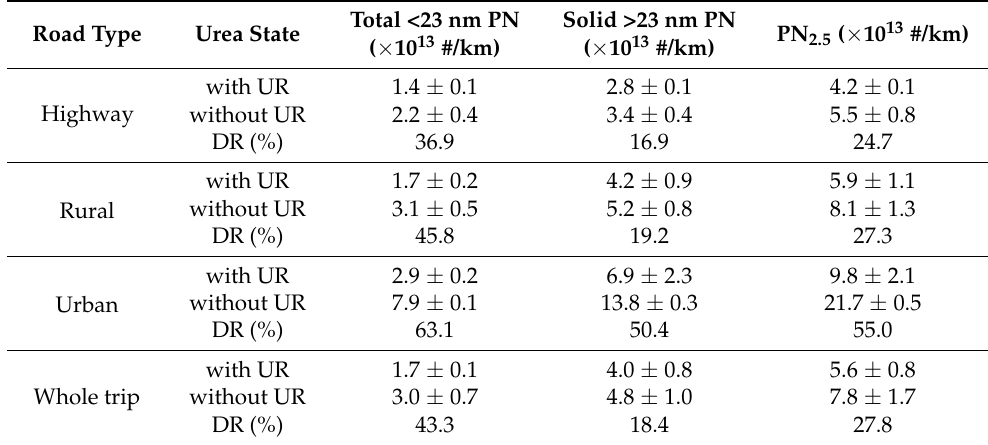
Table 4. On-road PN EFs of the tested truck on different road